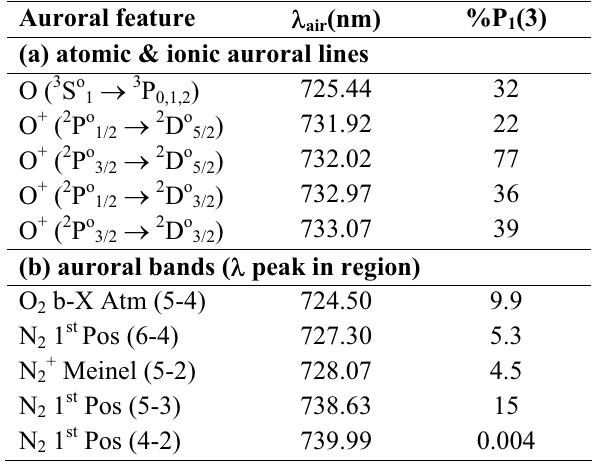
Table 3. Airglow and auroral, atomic and ionic lines and molecular bands in the OH(8–3) region, their wavelength of peak intensity within the interval λ 723nm to λ 741nm and their intensity relative to OH(8–3) P 1 (3) (scaled from Fig.